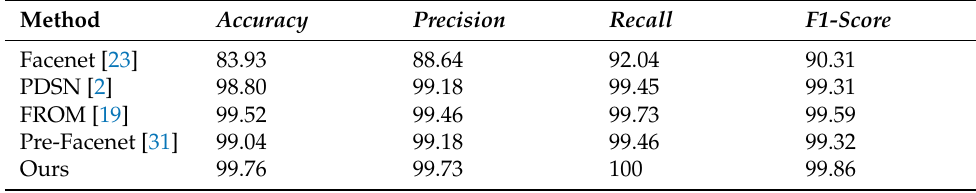
Table 4. Comparison with other state-of-the-art methods on